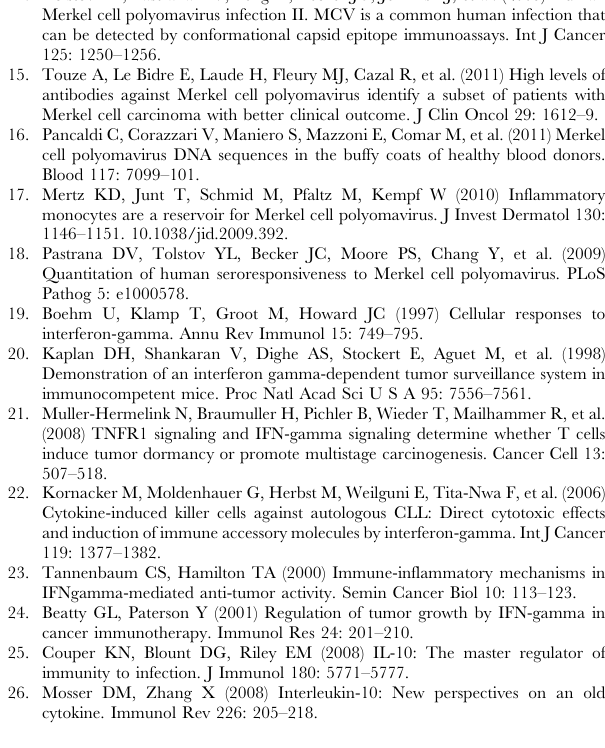
Figure S1 Cytokine and proliferation responses in the 15 MCPyV seropositve (A) and 15 seronegative (B) subjects with the 2.5 m g/ml MCPyV antigen ( & ) and media ( % ). (PDF) Figure S2 Cytokine responses versus m g/ml MCPyV IgG titers in the 15 seropositive subjects. Responses from a seropositive subject with strong MCPyV-specific cytokine respons-